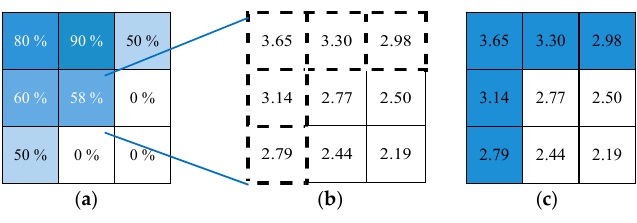
Figure 7. Water fractions and the proposed modified binary pixel swapping (MBPS) for spatial allocation of sub-pixels for a given pixel; ( a ) water fractions, ( b ) identification of sub-pixel locations with highest attractiveness, highlighted by dash-lines, and ( c ) allocation of water and non-water sub-pixels. The values of sub-pixels represent their attractiveness toward the water class.